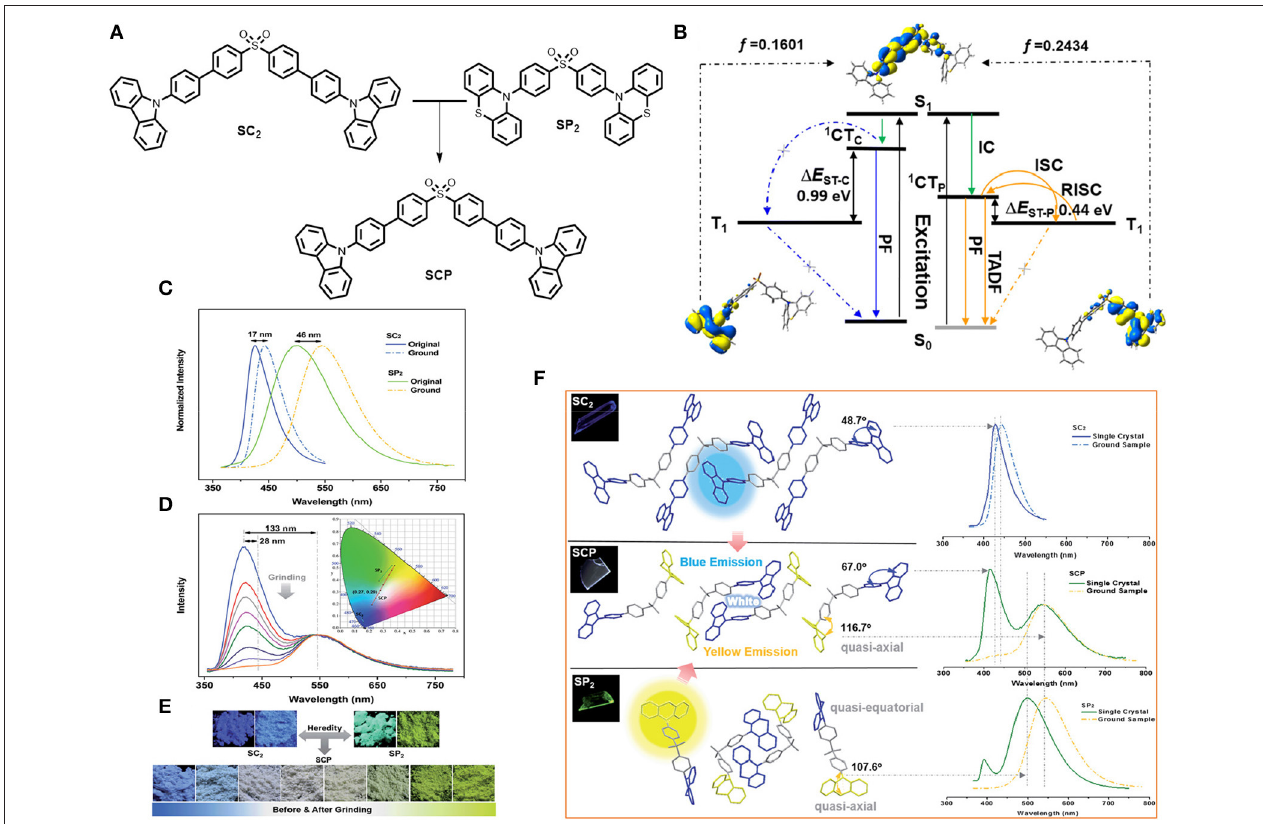
FIGURE 16 | (A) Molecular configuration of the compounds. (B) Decays associated with corresponding electronic transitions in SCP. (C) PL study of the parent molecules in solid-powder form. (D) Mechanochromism in SCP molecule. (E) Compound images under the UV-irradiation of 365nm. (F) Single crystal analysis and crystalline molecular packing of the compounds along with corresponding photo luminence spectra of the single crystals and normal compounds. Insets: fluorescence images (365nm UV-excitation). Reproduced with permission from Xu et al. (2016). Copyright © The Royal Society of Chemistry.